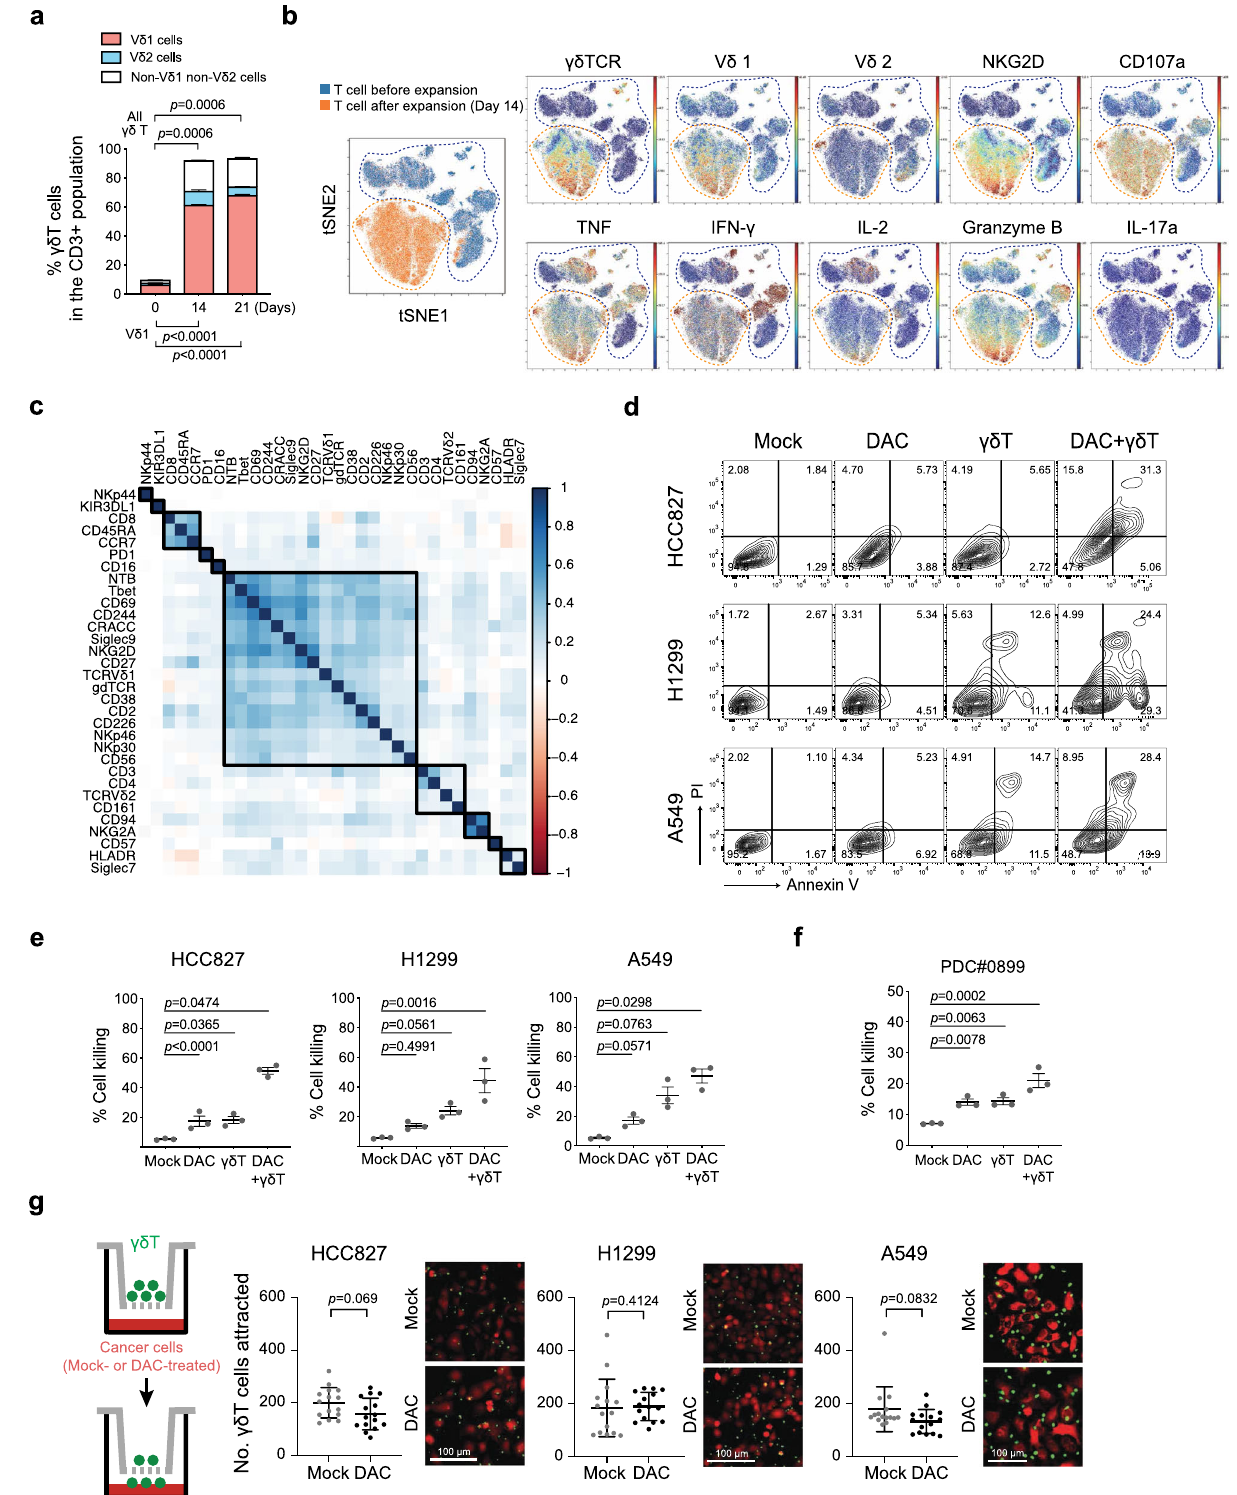
mimicking the effect of DAC pretreatment (Fig. 3g, h). As anticipated, DAC treatment of ICAM1 -knockout cells failed to enhance immune synapse formation between lung cancer and γδ T cells (Fig. 3i). Collectively, the data suggest that ICAM-1- mediated adhesion and stabilization of the synaptic structure is critical for DAC ’ s potentiating effects on γδ T cell antitumor immunity.